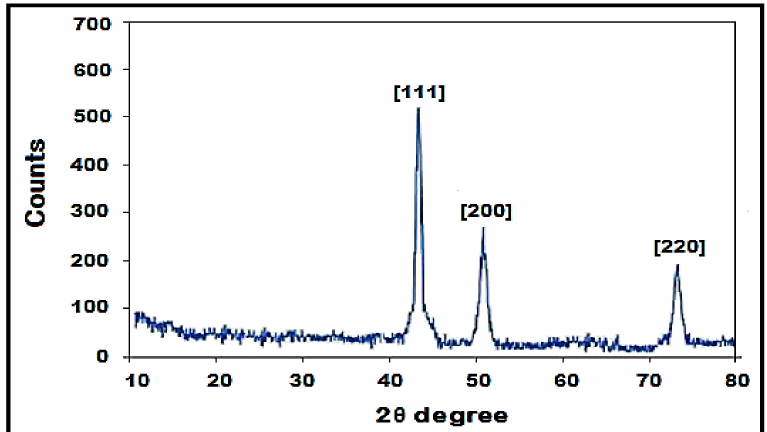
Figure 6. XRD pattern of synthesized Copper nanoparticles using Fortunella margarita leaves’